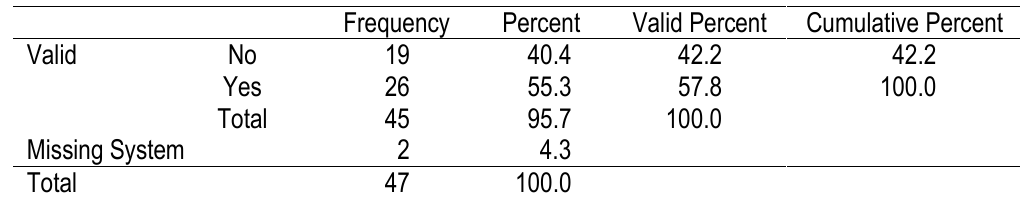
Table 2. “I think it is more challenging to learn science via distance education than the case of other subjects related to Social Sciences or Humanities (e.g., Economics, History, Language, Law, Management, etc).”